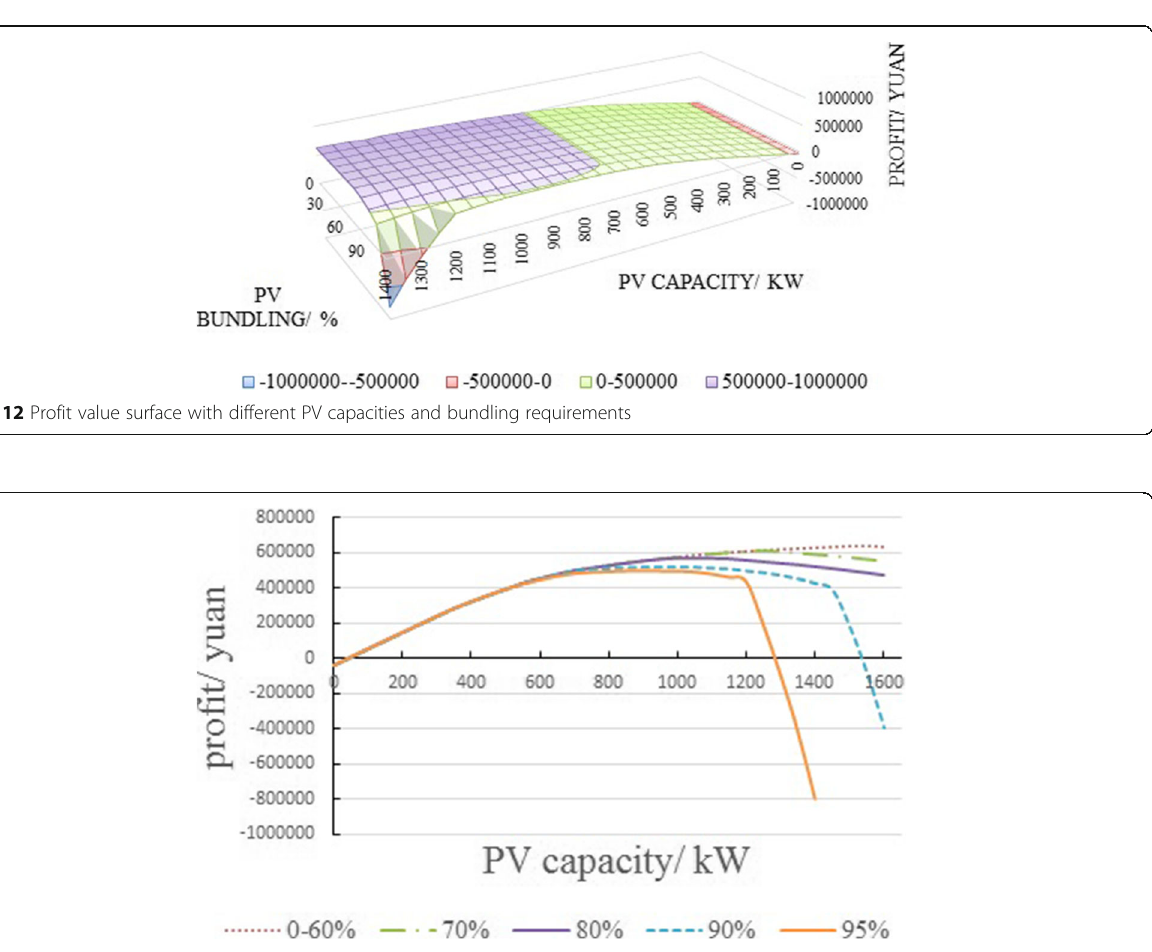
Fig. 13 Profit value curves with different PV bundling requirements